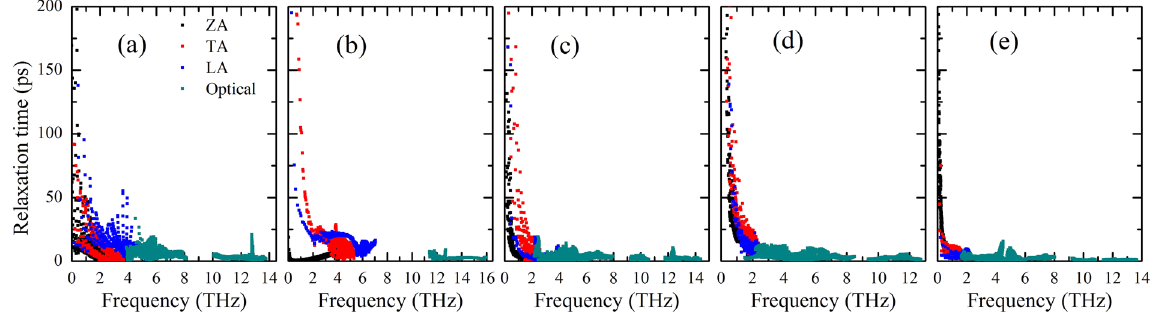
Figure 7. Room temperature relaxation time of different phonon modes as a function of frequency for: ( a ) α -phosphorene, ( b ) β -phosphorene, ( c ) γ -phosphorene, ( d ) δ -phosphorene, and ( e ) ζ